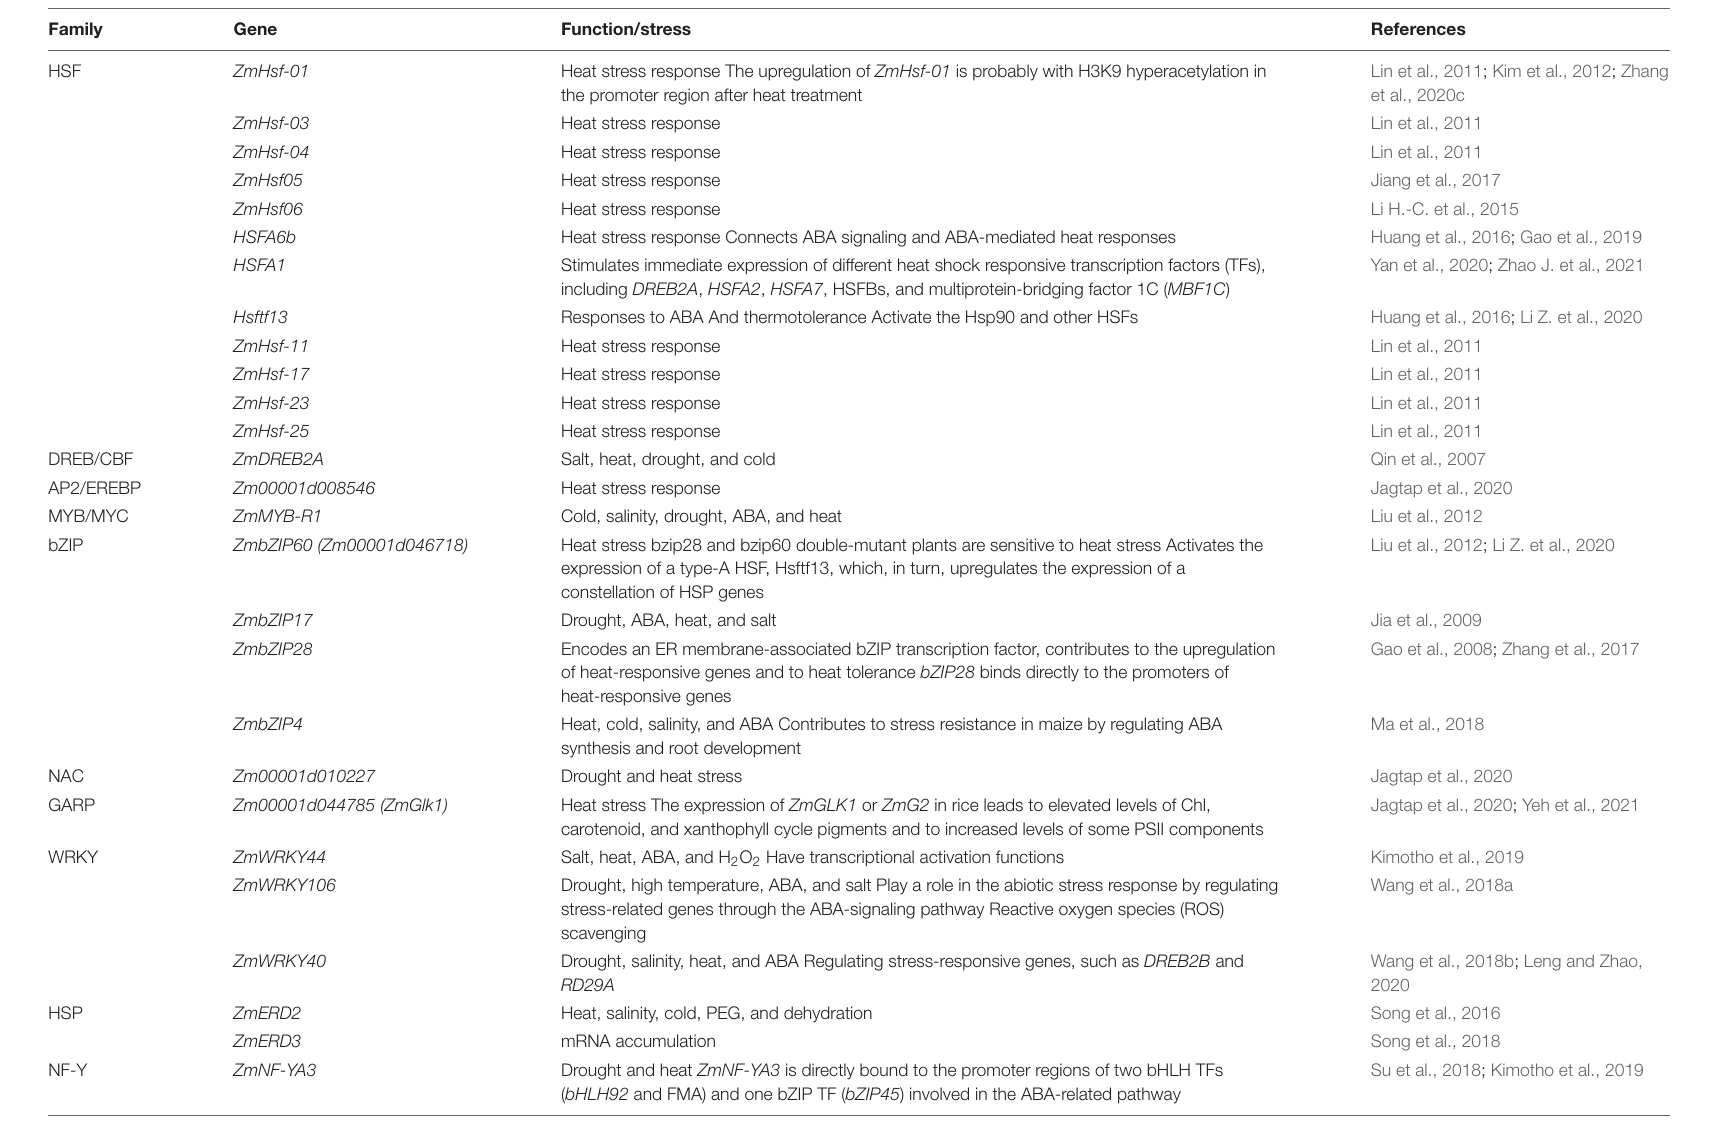
TABLE 1 | Heat stress-related transcription factor (TF) families in maize.